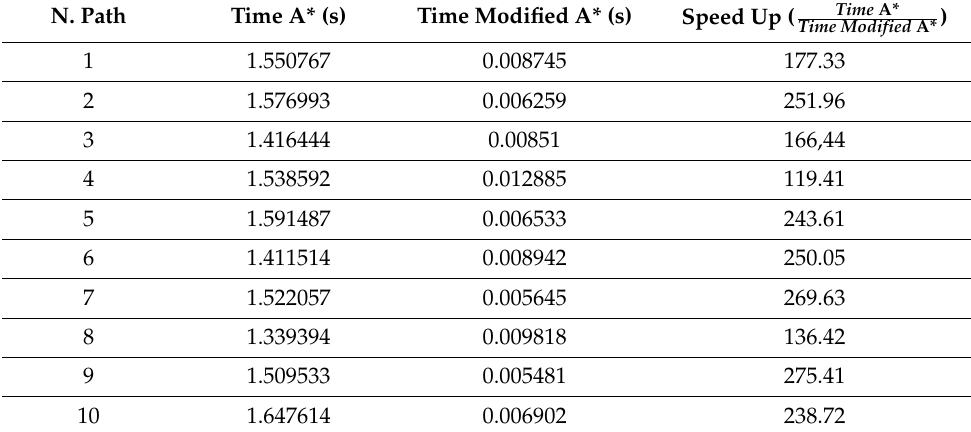
Table 2. Comparation between the execution time of the A* path panner and the presented path